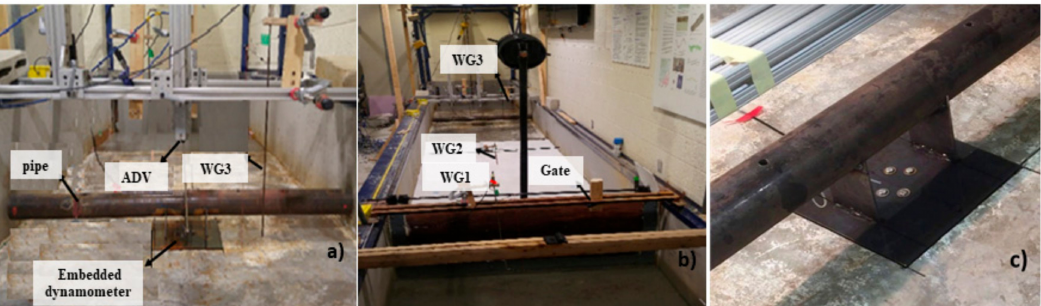
Figure 2. ( a ) Downstream view of pipe, dynamometer, ADV and wave gauge, ( b ) downstream view of flume and gate and ( c ) close view of pipe, supports and the base